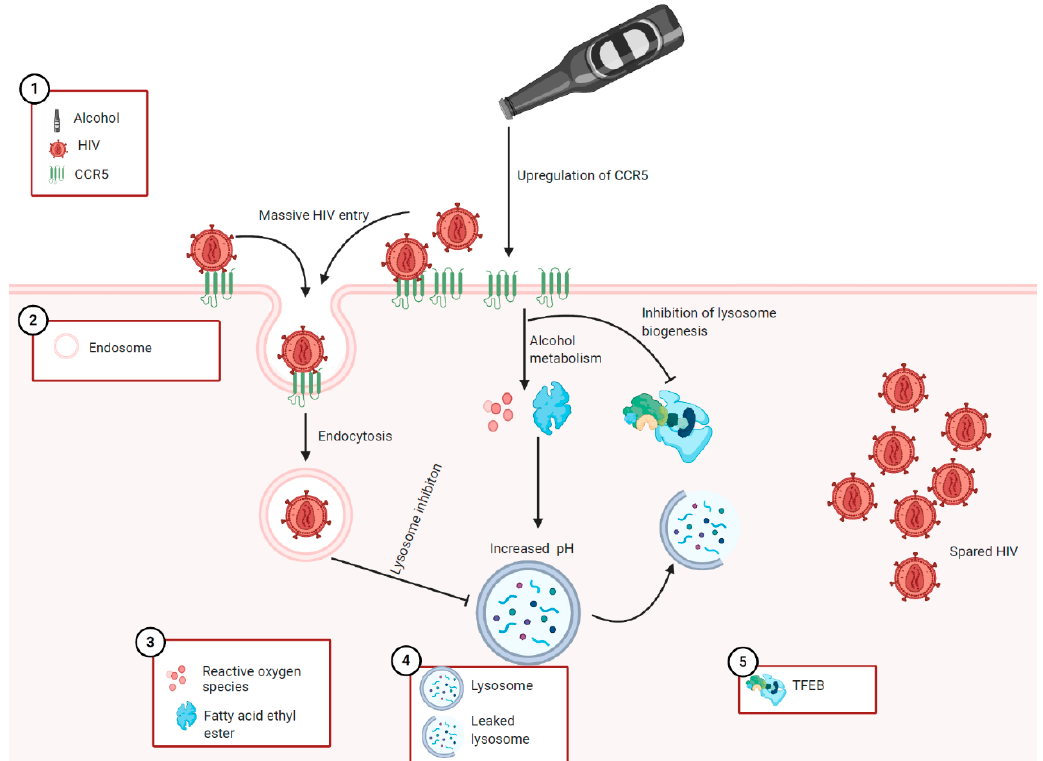
Figure 3. Proposed mechanisms of HIV-induced pancreatitis potentiated by alcohol: Visual illustration of the proposed mechanisms explaining how alcohol and its metabolites potentiates HIV-induced pancreatic damage. The mechanistic steps include: (1) at the surface of the acinar cell membrane, ethanol or its metabolites upregulating CCR5, leading to massive HIV entry into acinar cells; (2) HIV becomes internalized by the endosome and is fated for degradation by the pH-dependent lysosome; (3) alcohol becomes metabolized oxidatively and non-oxidatively to yield ROS and fatty acid ethyl esters (FAEE), respectively; (4) the lysosome becomes impaired due to alcohol-induced pH elevation or disruption of lysosome membrane by ROS and FAEE; (5) persistent lysosome damage due to alcohol-induced inhibition of lysosome biogenesis. The overall effects of these mechanisms lead to the accumulation and persistence of HIV, which should have been degraded by lysosomes; hence, the accumulated HIV induces the damage highlighted in Figure